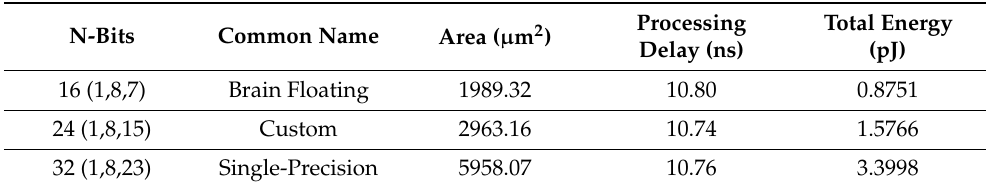
Table 5. Comparison of N-bit floating point multiplier.